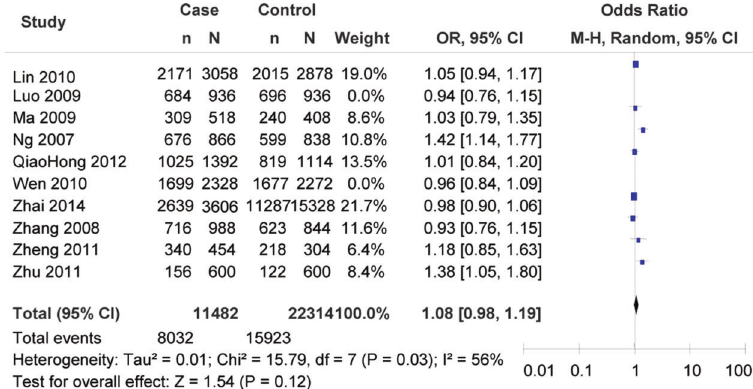
Figure 3 - Meta-analysis of the association between the rs11196218A/G polymorphism and T2DM risk (subgroup analyses for HWE in the control group: G vs. A). n indicates the total number of G alleles, and N indicates the total number of G alleles plus A